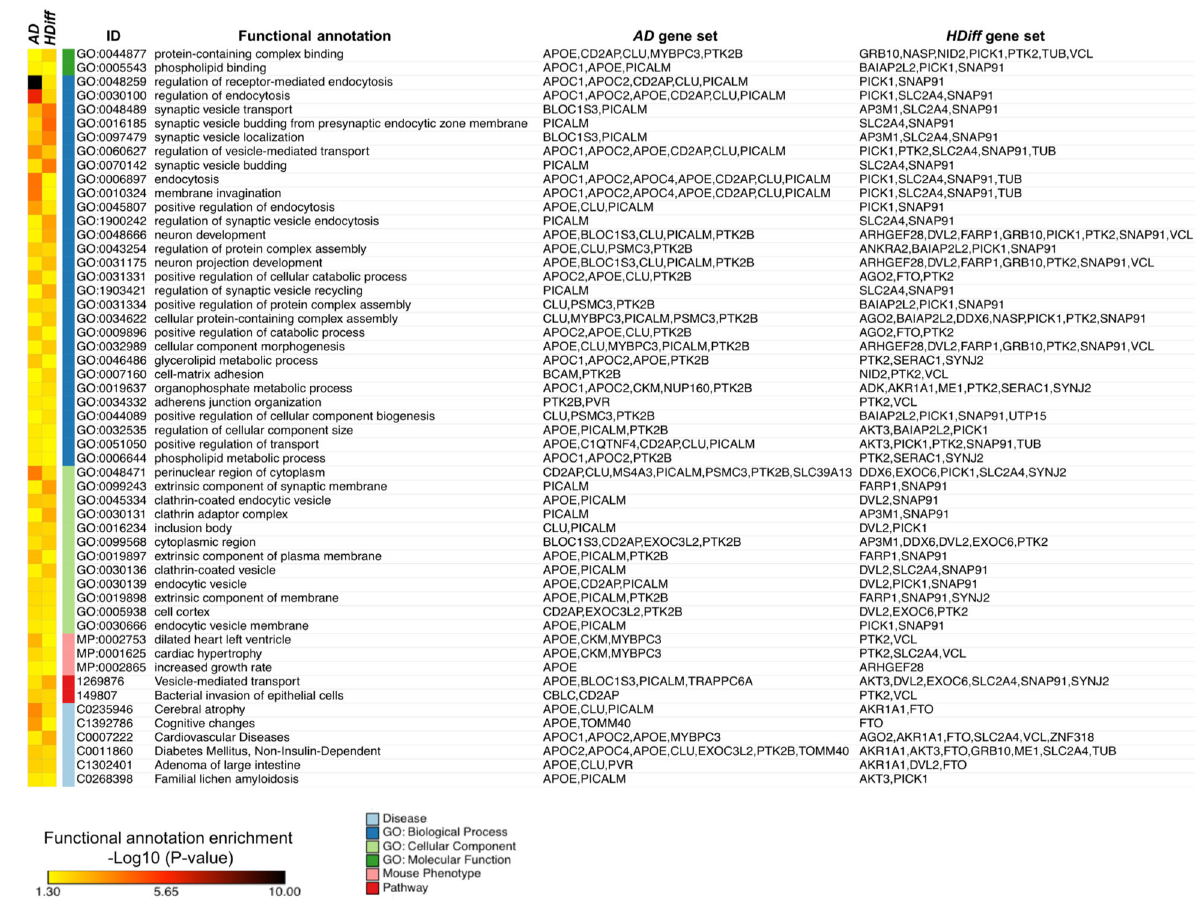
Fig. 5 Gene functional enrichment analysis. Functional annotations enriched at uncorrected P value <0.05 identi fi ed by ToppCluster tool among prioritized HDiff and AD genes. None of the annotation survived multiple testing corrections at FDR level 0.05, however, interesting functions are enriched even at the nominal